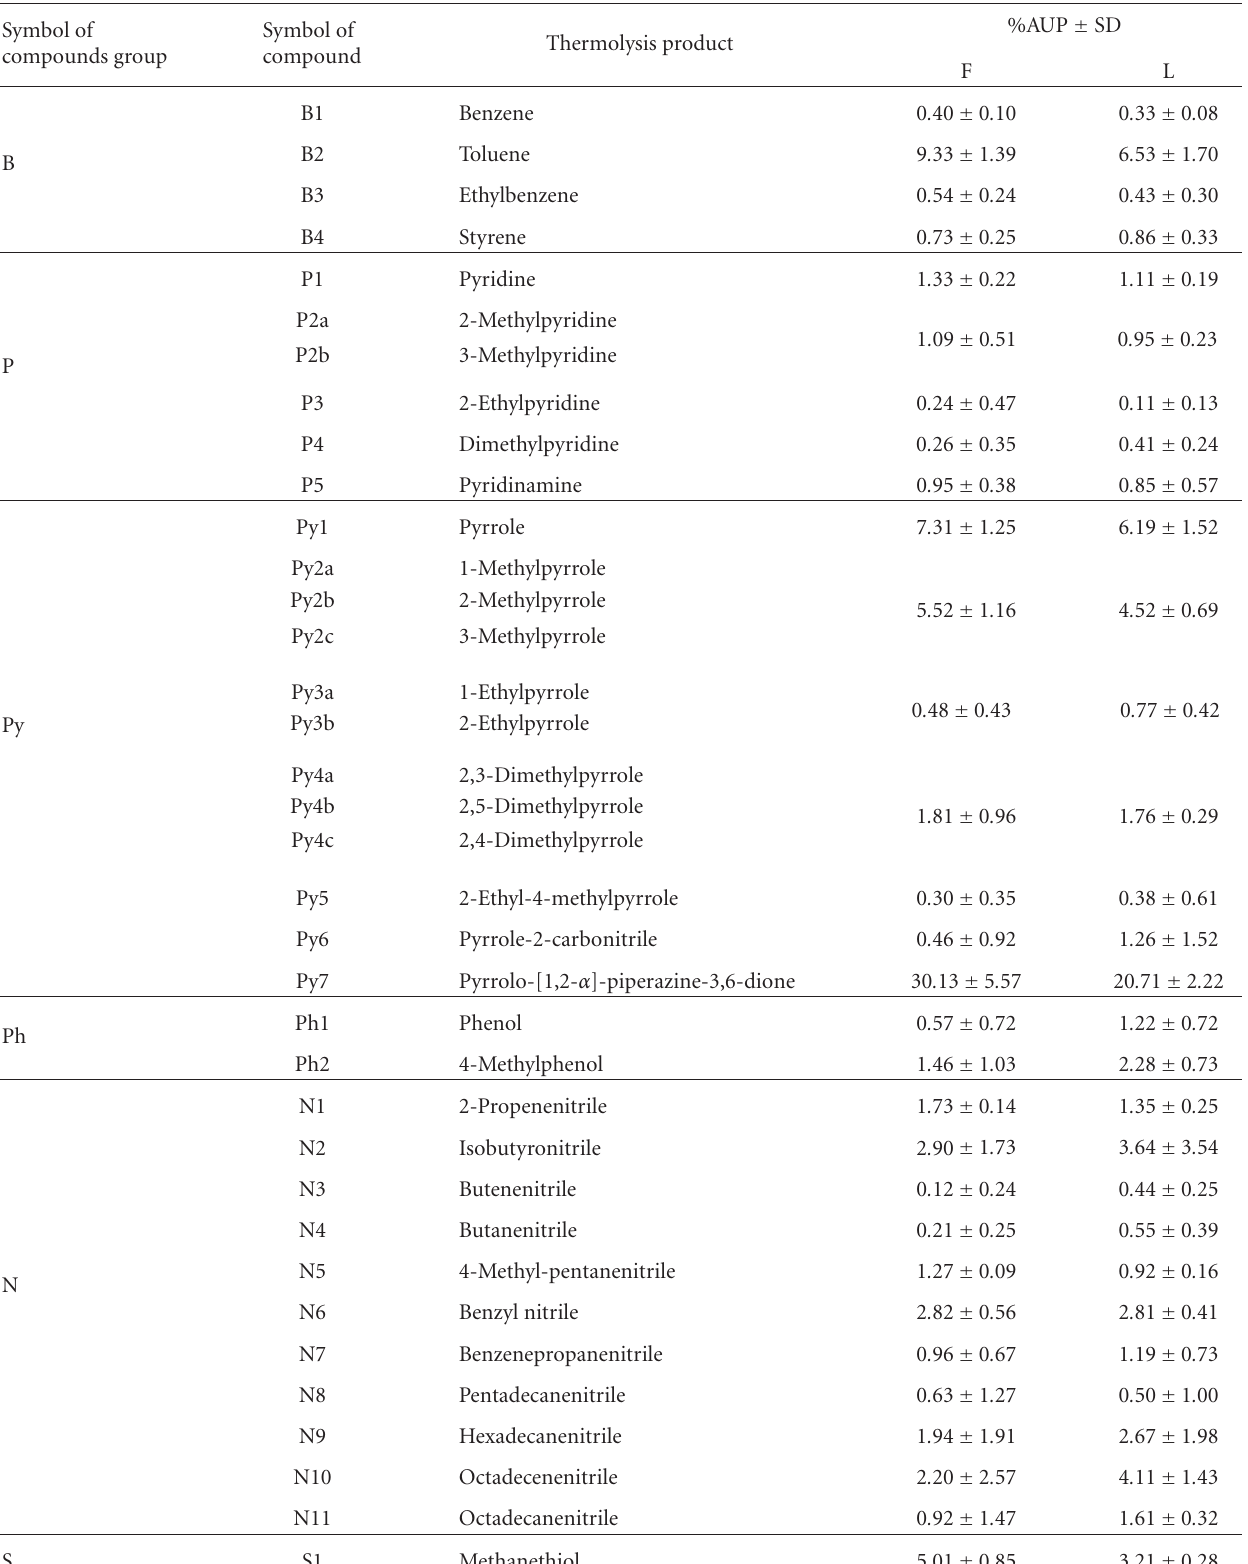
Table 1: The quantity of particular thermolysis products derived from the components of compact part of the human bone preserved by deep-freezing (F) or lyophilization (L) and used for transplantation, expressed as percentage of a given analyte in a total identified